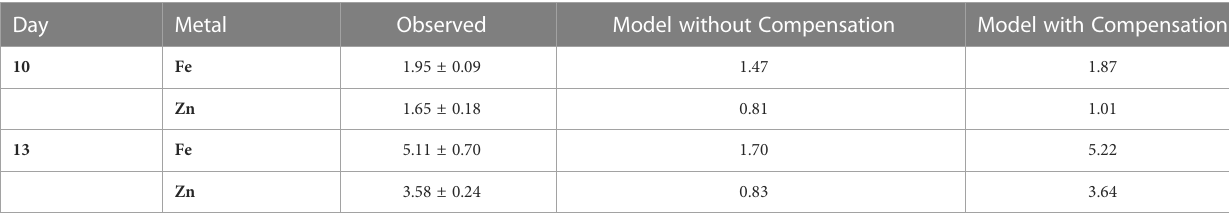
TABLE 5 Fe and Zn in biomass of the wbc19 mutant under Kan exposure as observed (± SD) and in the model without and with compensation (as depicted in Figure 2 ).